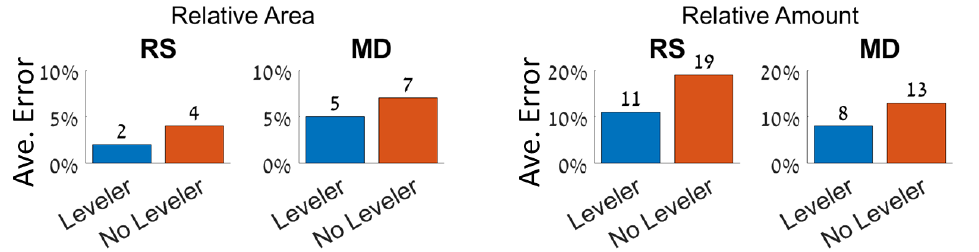
Figure 13. Percent average error in total amount of individuals over eight classes in the different data- sets. In relative area ( left ), the error for photomosaic that have been orthorectified ranges between two to five percent, and for the naïve photomosaics from four to seven percent, with similar effect in both data-sets. In relative amount ( right ), the error for photomosaic that have been orthorectified ranges between eight to 11 percent, and for the naïve photomosaics from 13 to 19 percent, with more effect in the RS